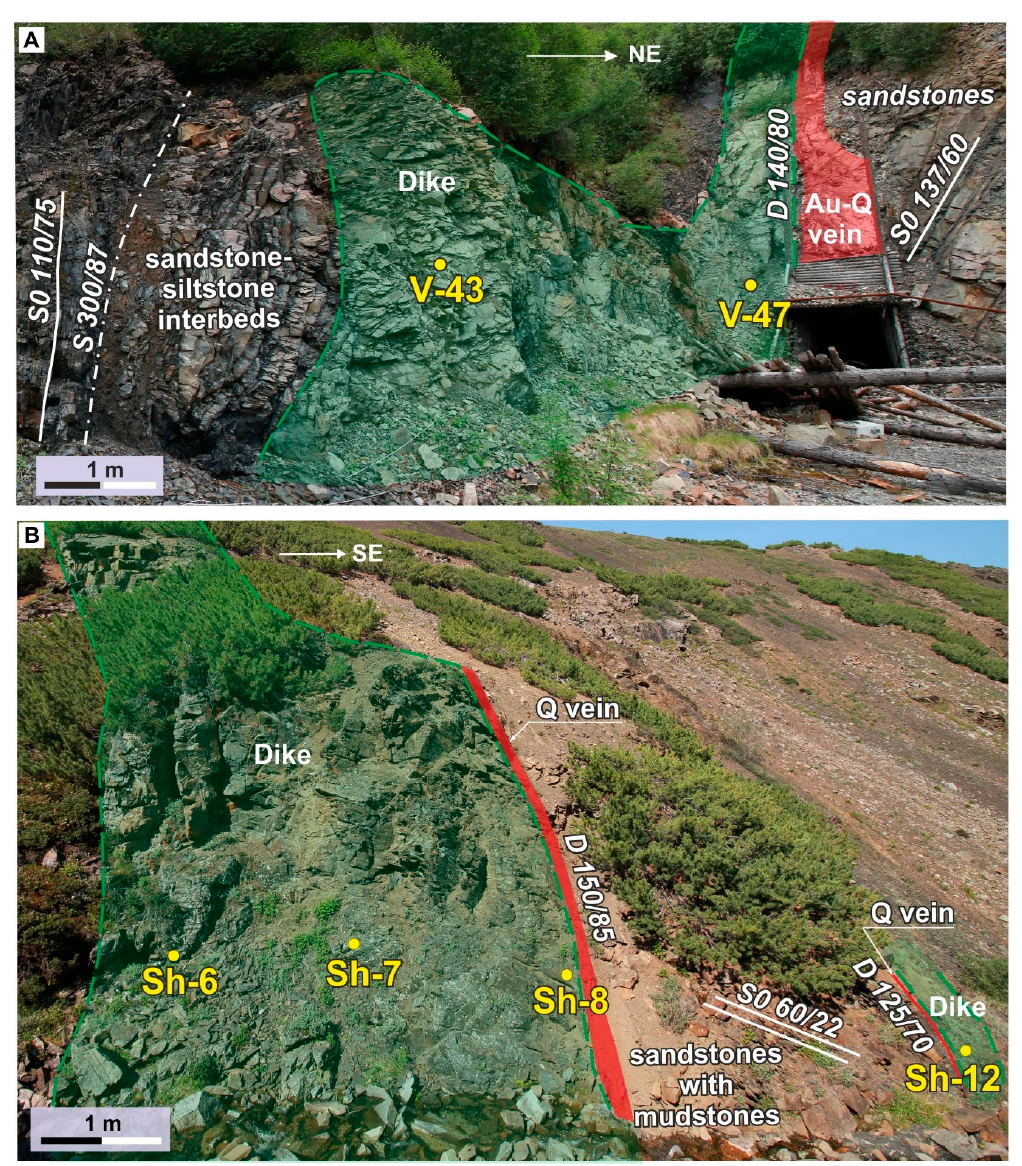
Figure 3. Photographs of dated dikes and locations of samples: ( A ) Vyun deposit, ( B ) Shumniy ore occurrence. Attitude: S0—bedding, S—fault, D—dike.